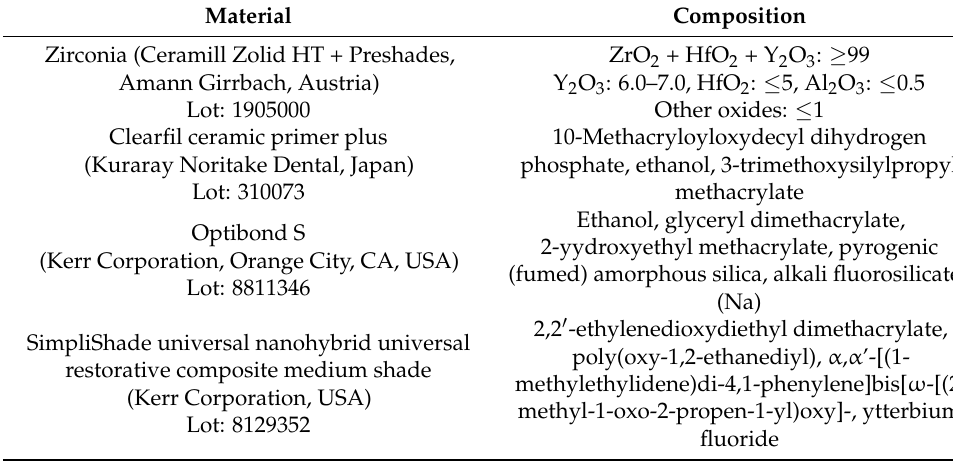
Table 1. The materials used in this